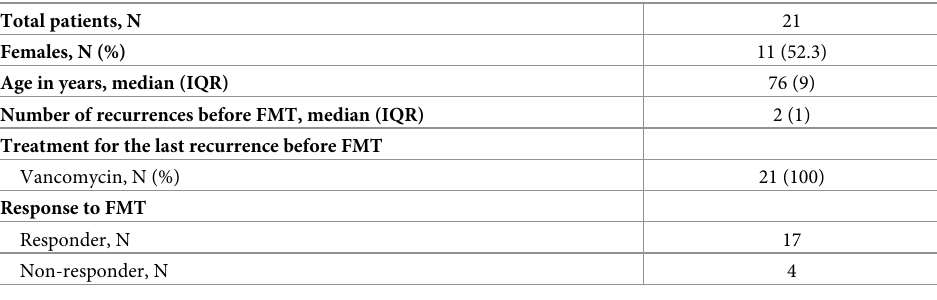
Table 1. Basic demographics and clinical characteristics.